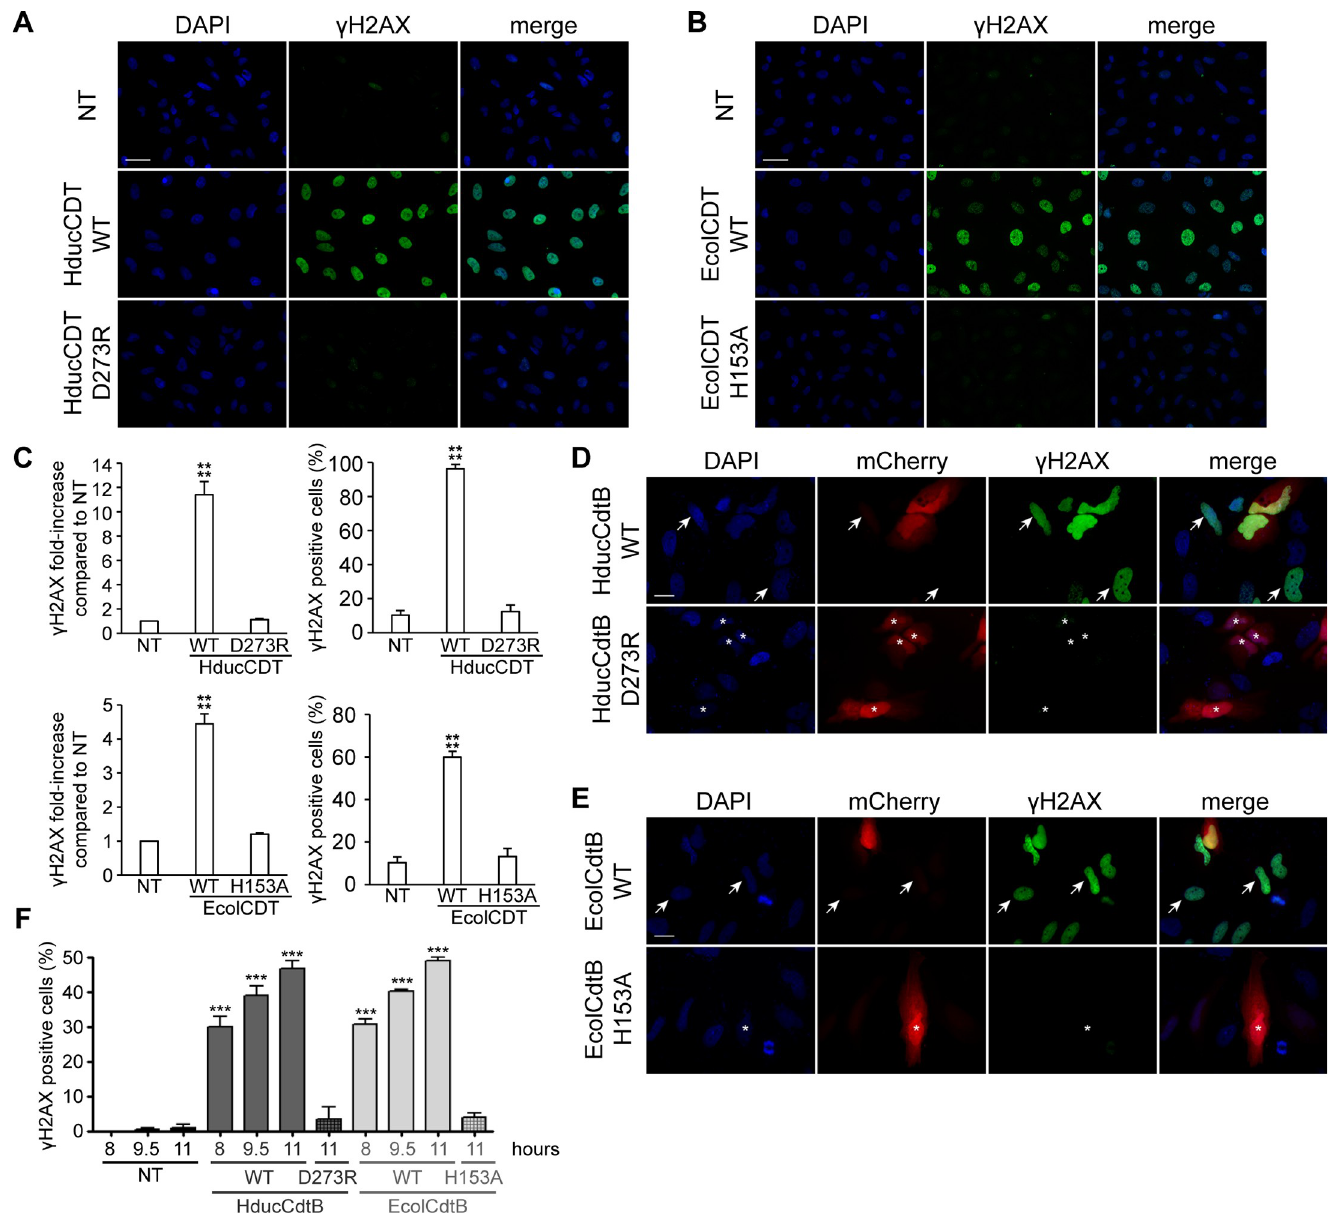
Fig 1. DNA damage induction in HeLa cells after CDT holotoxin treatment or mCherry-CdtB expression. A. Representative images of γ H2AXimmunofluorescence and DAPI staining from HeLa cells treated with 35 ng/mL of WT or D273R HducCDT holotoxin for 24 h. Scale bar: 50 μ m. B. Representative images of γ H2AX immunofluorescence and DAPI staining from HeLa cells treated with 2.5 ng/mL of WT or H153A EcolCDT holotoxin for 24 h. Scale bar: 50 μ m. C. Quantification of γ H2AXsignal in HeLa cells left untreated (NT), treated with 20 ng/mL of WT or D273R HducCDT or with 2.5 ng/mL of WT or H153A EcolCDT for 24 h, represented as the mean fluorescence intensity per cell (normalised to 1 for the untreated condition) or as the proportion of γ H2AX positive cells. Results present the mean ± SD of at least three independent experiments; statistical differences were analysed between treated and untreated conditions ( ���� P < 0.0001). D. Representative images of mCherry-HducCdtB localisation, γ H2AXimmunofluorescence and DAPI staining from HeLa cells expressing WT or D273R HducCdtB in fusion with mCherry. Immunostaining was performed 11 h after transfection. Cells with high expression (stars) or low expression (arrows) of WT mCherry-HducCdtB are indicated. Scale bar: 20 μ m.E. Representative images of mCherry-EcolCdtB localisation, γ H2AX immunofluorescence and DAPI staining from HeLa cells expressing WT or H153A EcolCdtB in fusion with mCherry. Immunostaining was performed 11 h after transfection. Cells with high expression (stars) or low expression (arrows) of WT mCherry- EcolCdtB are indicated. Scale bar: 20 μ m.F. Quantification of γ H2AX positive HeLa cells left untransfected (NT), expressing WT or mutant (HducCdtB D273R or EcolCdtB H153A) CdtB in fusion with mCherry. Immunostaining was performed at the indicated time after transfection. Results present the mean ± SD of at least three independent experiments; statistical differences were analysed between transfected and non-transfected conditions at each time point ( ��� P < 0.001).